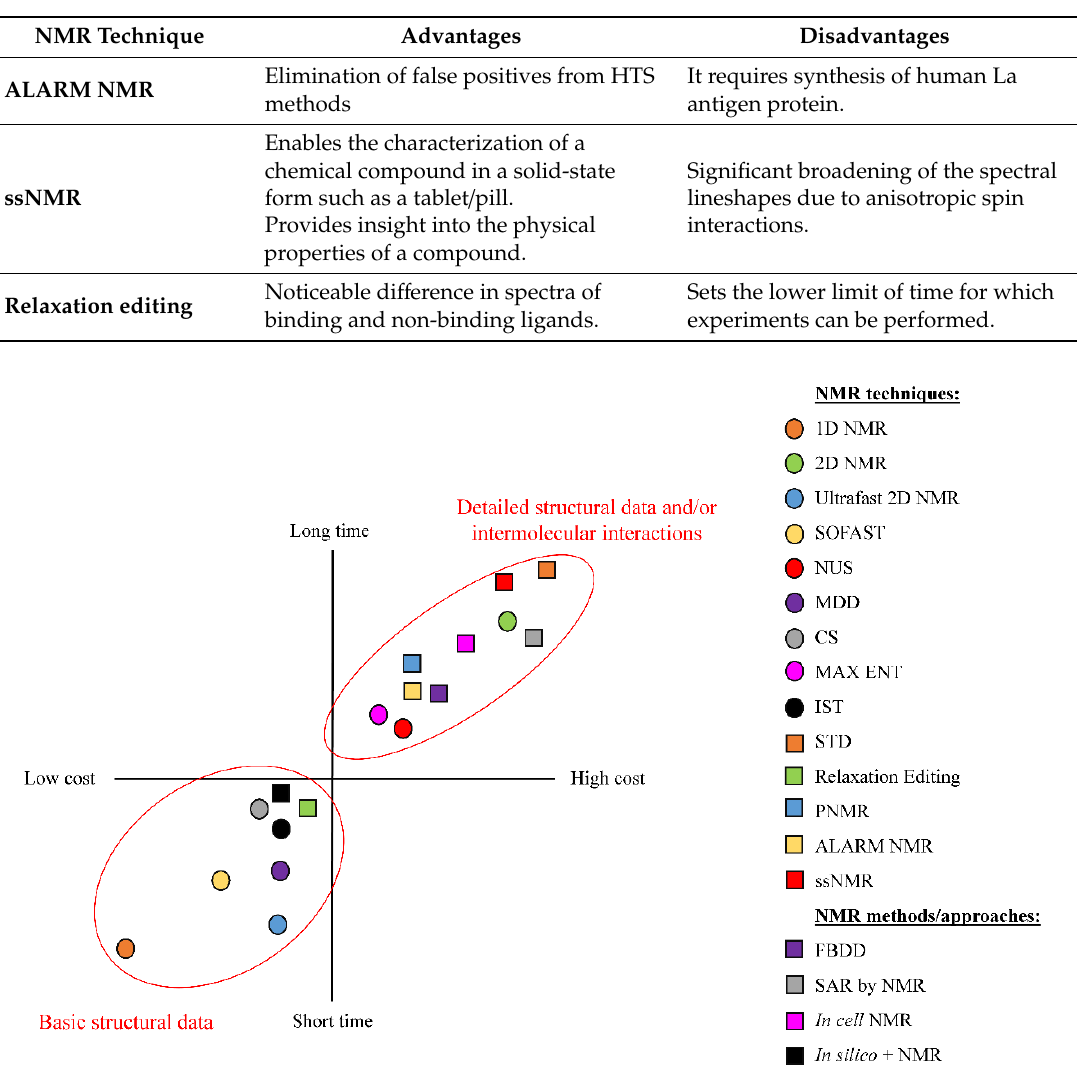
Scheme 2. Analysis of the cost and time between different NMR methods used in drug design. Meaning of some of the acronyms are listed below: SOFAST—Band-Selective Optimized Flip Angle